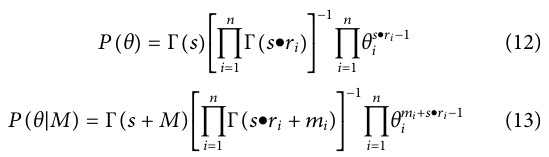
TABLE 2 The equations for delineating the IDR potential of the residential user.